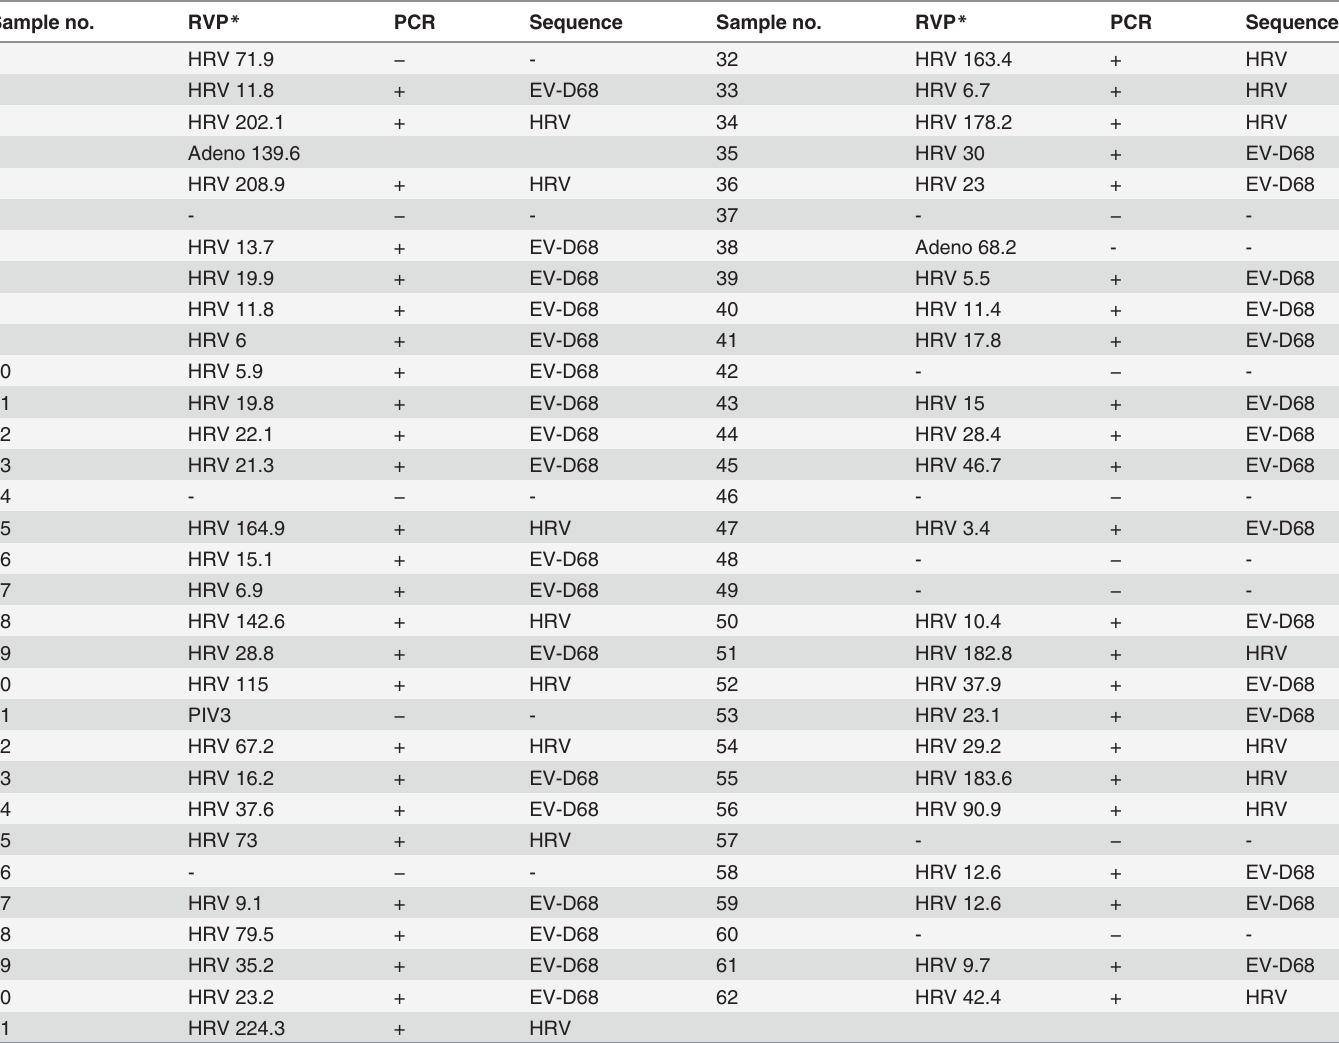
Table 1. RVP Signal, 5'-UTR PCR, and sequencing results. Sample